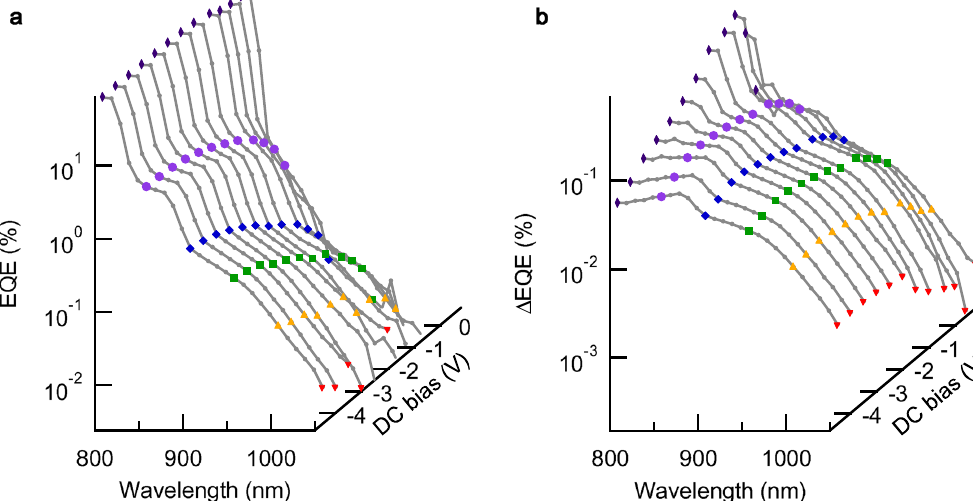
Figure 2. EQE and Δ EQE spectra measured at different applied DC bias voltages. ( a ) EQE spectra in the subbandgap region measured by applying the external DC bias voltage. The solid symbols indicate the EQE at 800, 850, 900, 950, 1,000, and 1,050 nm of the interband excitation, respectively. ( b ) Δ EQE spectra in the subbandgap region measured with the additional subbandgap excitation of 0.5 eV. The DC bias was changed from 0.8 V to − 4.5